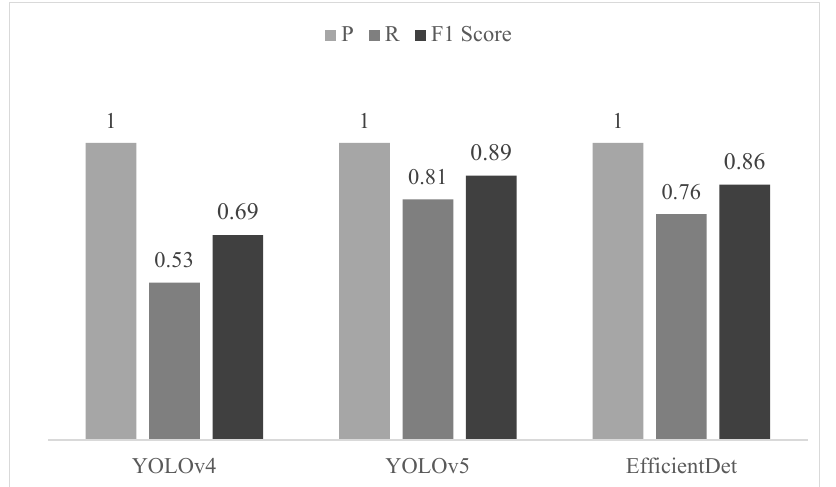
Figure 17. Results from the calculation of metrics to evaluate the testing dataset.